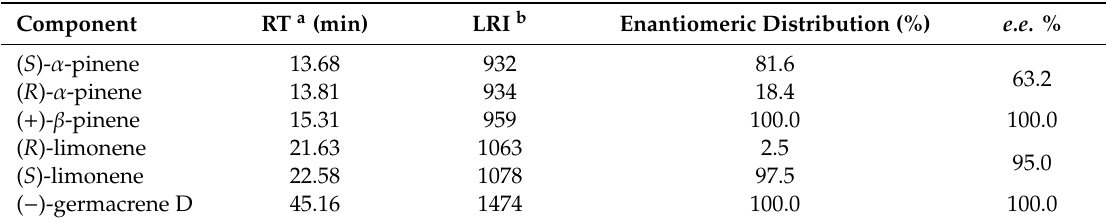
Table 2. Enantiomeric excess of some constituents from Coreopsis triloba S.F. Blake.